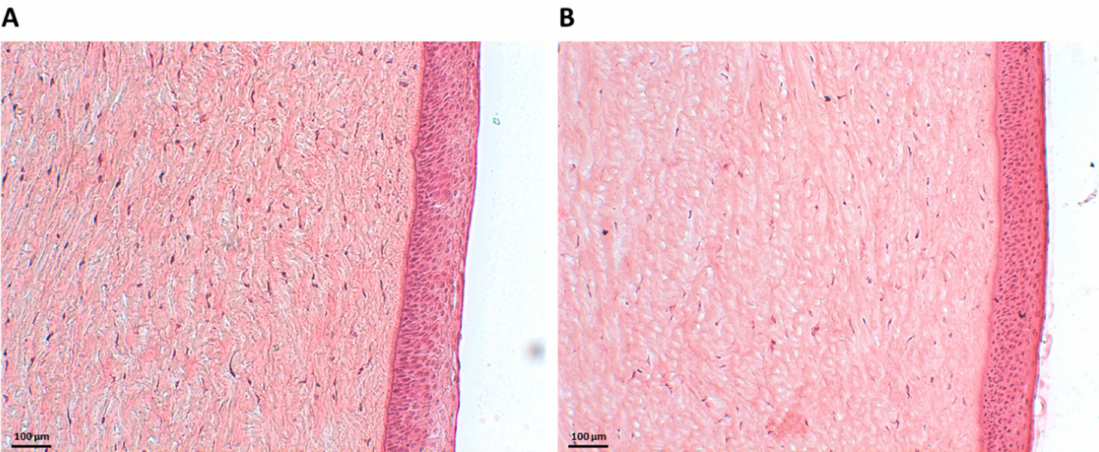
Figure 2. Histology of porcine corneal epithelium after incubation with NHs ( A ) or PBS (CTR) ( B ) for 6 h. Scale bars: 100 µ